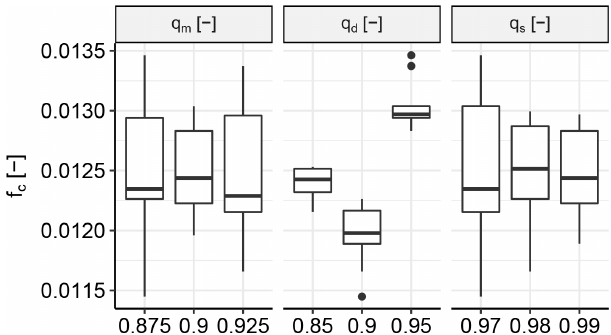
Figure 11. Sensitivity of f c , which is the mean of the absolute dif- ferences in correlation between the synthetic and the observed de- scriptor sets for all locations, to the three main settings used for the statistical analysis in Sect. 4. q m is the quantile threshold for the GPDs, q d is the quantile threshold for HT04, and q s is the quantile threshold for the simulation from